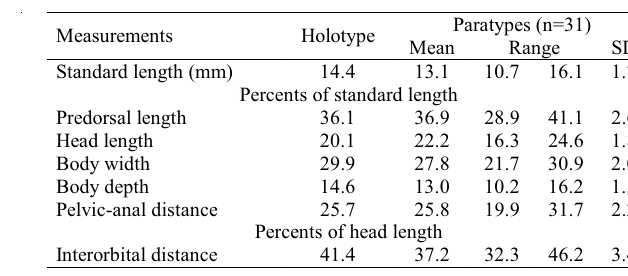
Table 1. Morphometric data of Scoloplax baskini . SD = stan- dard